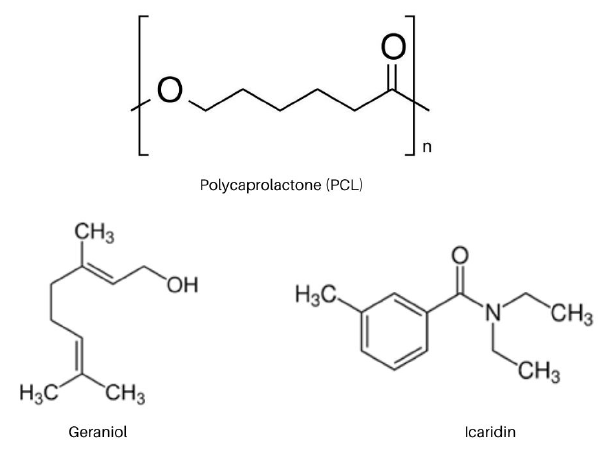
Figure 10. Chemical structures of Poly- ε -caprolactone (PCL), geraniol and icaridin.